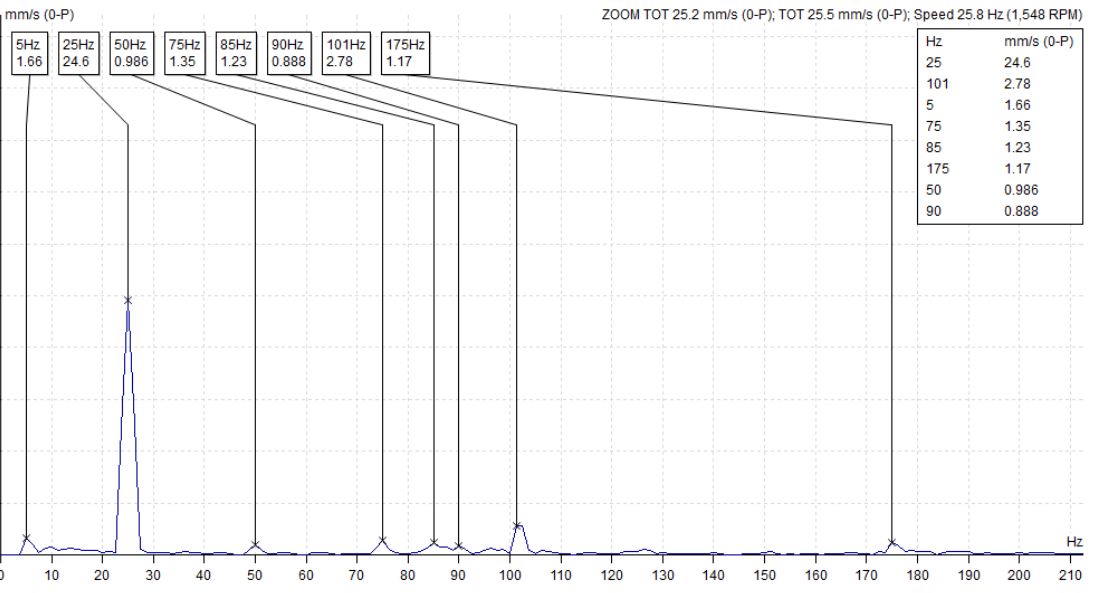
Figure 12. Bearing vibration spectrum.